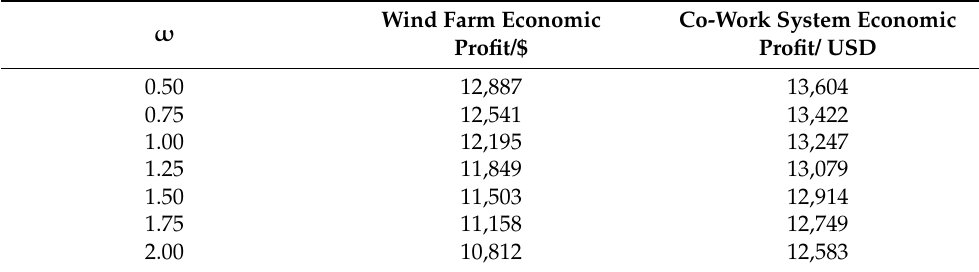
Table 5. Economic benefits of the wind farm with different values of coefficient of deviation.